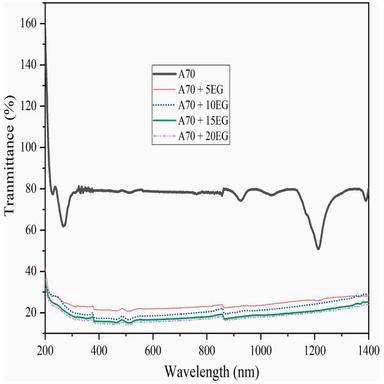
Schematic diagram of transmittance of base PCM and SS-PCM composites.